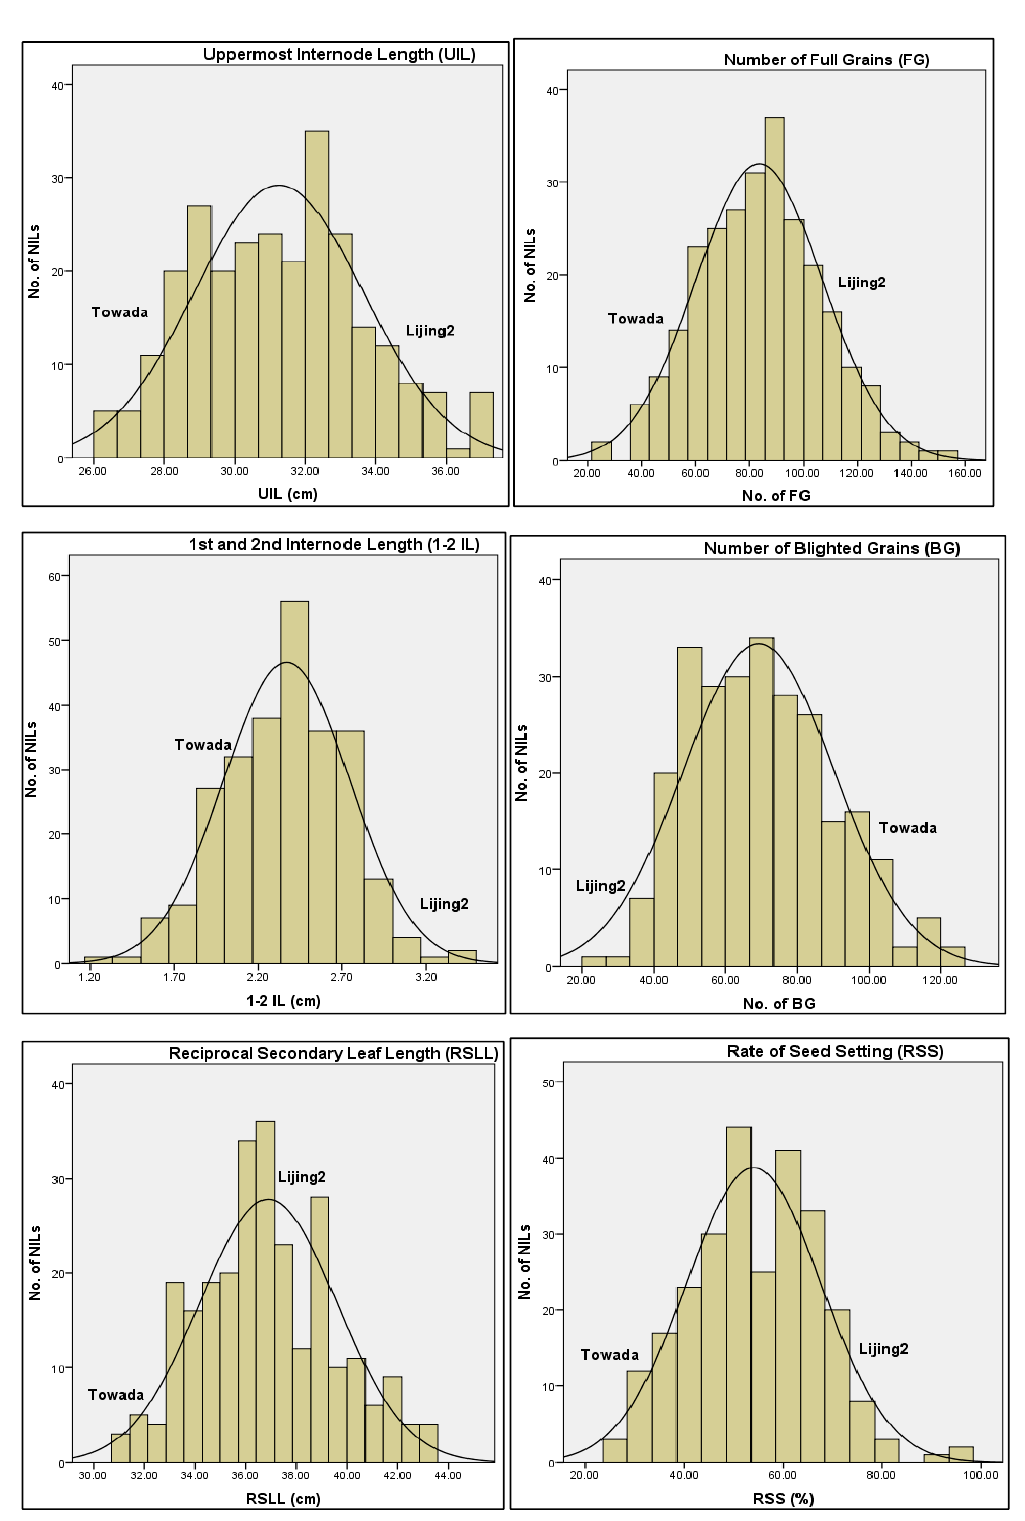
Figure 1. Distribution pattern of six morphological traits, full grain (FG), upper most internode length (UIL), 1st and 2nd internode length (1-2IL), blighted grains (BG), reciprocal secondary leaf length (RSLL), and rate of seed setting (RSS) in Near-isogenic lines (NILs) populations of rice plants grown under cold stress condition.